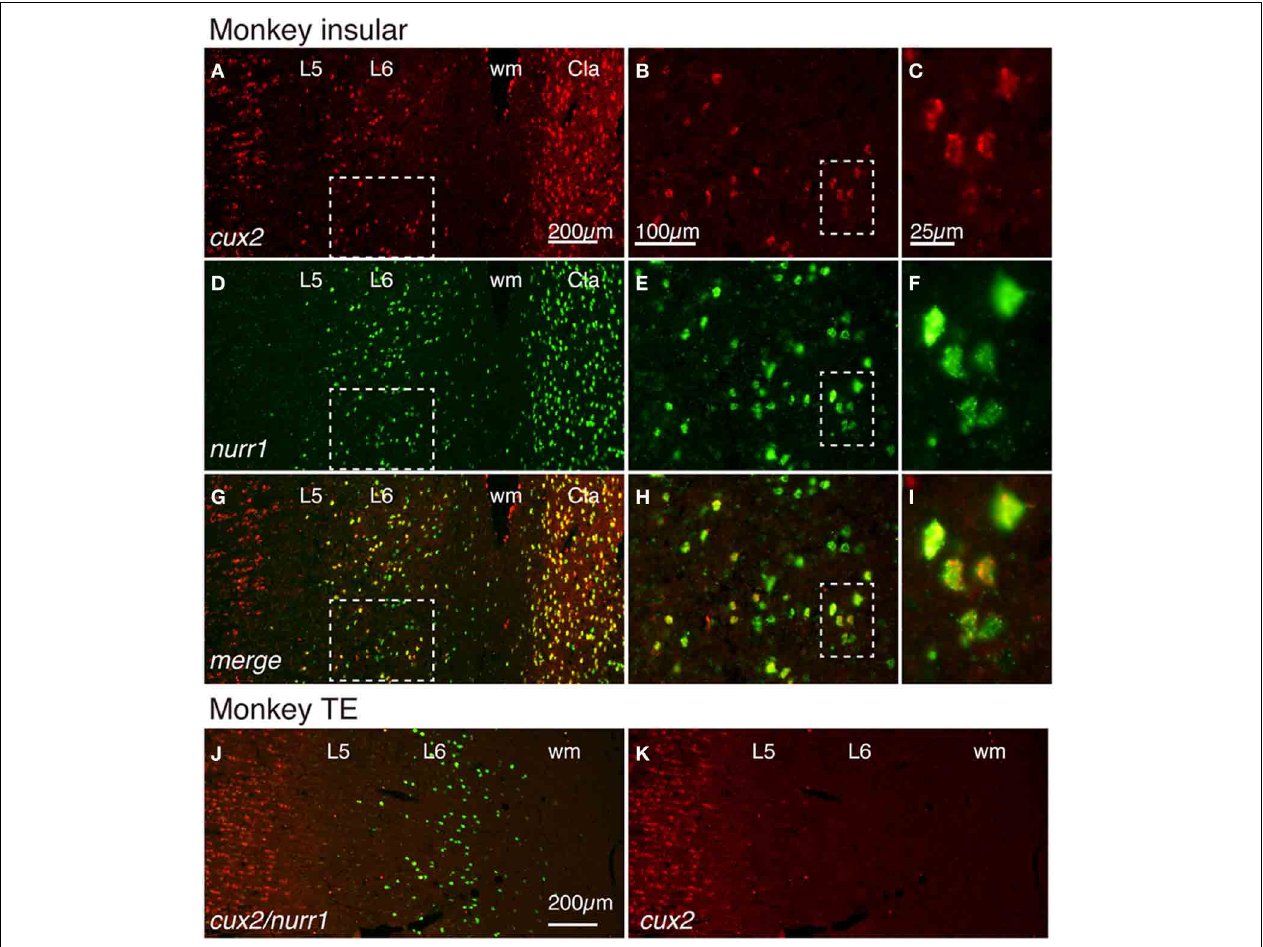
FIGURE 3 | Colocalization of cux2 and nurr1 mRNAs in the claustrum and insular cortex of the monkey brain. (A,D,G) Double ISH of cux2 (red) and nurr1 (green) mRNAs in the monkey brain section that spans the deep layers 5 (L5) and 6 (L6) of the insular cortex and the claustrum. Left side is to the pia matter. Red (A) , green (D) , and merged (G) channels were shown for the same section to demonstrate the colocalization of cux2 and nurr1 mRNA